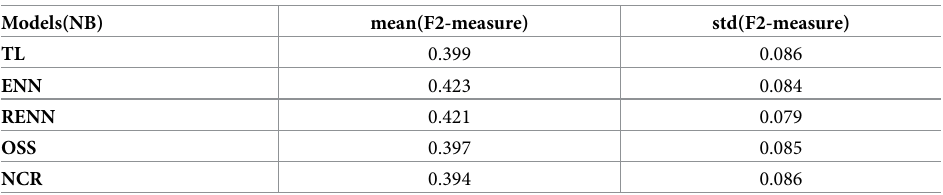
Table 5. F2-measure of